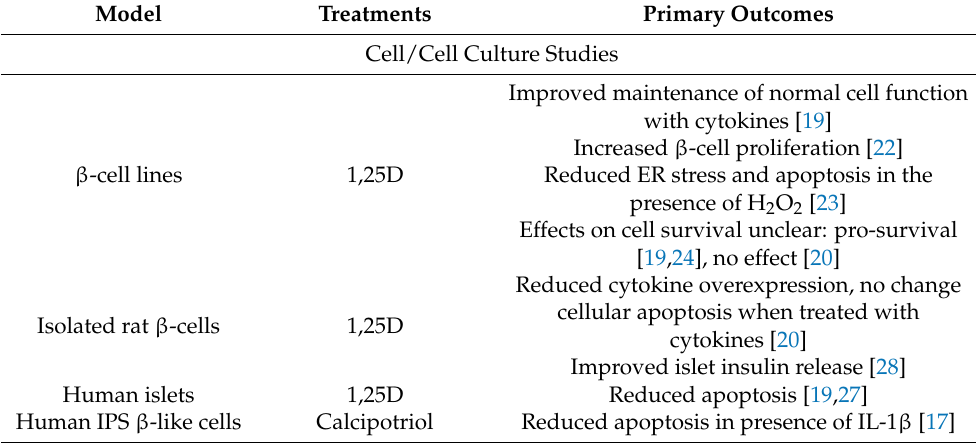
Table 3. Summary of study